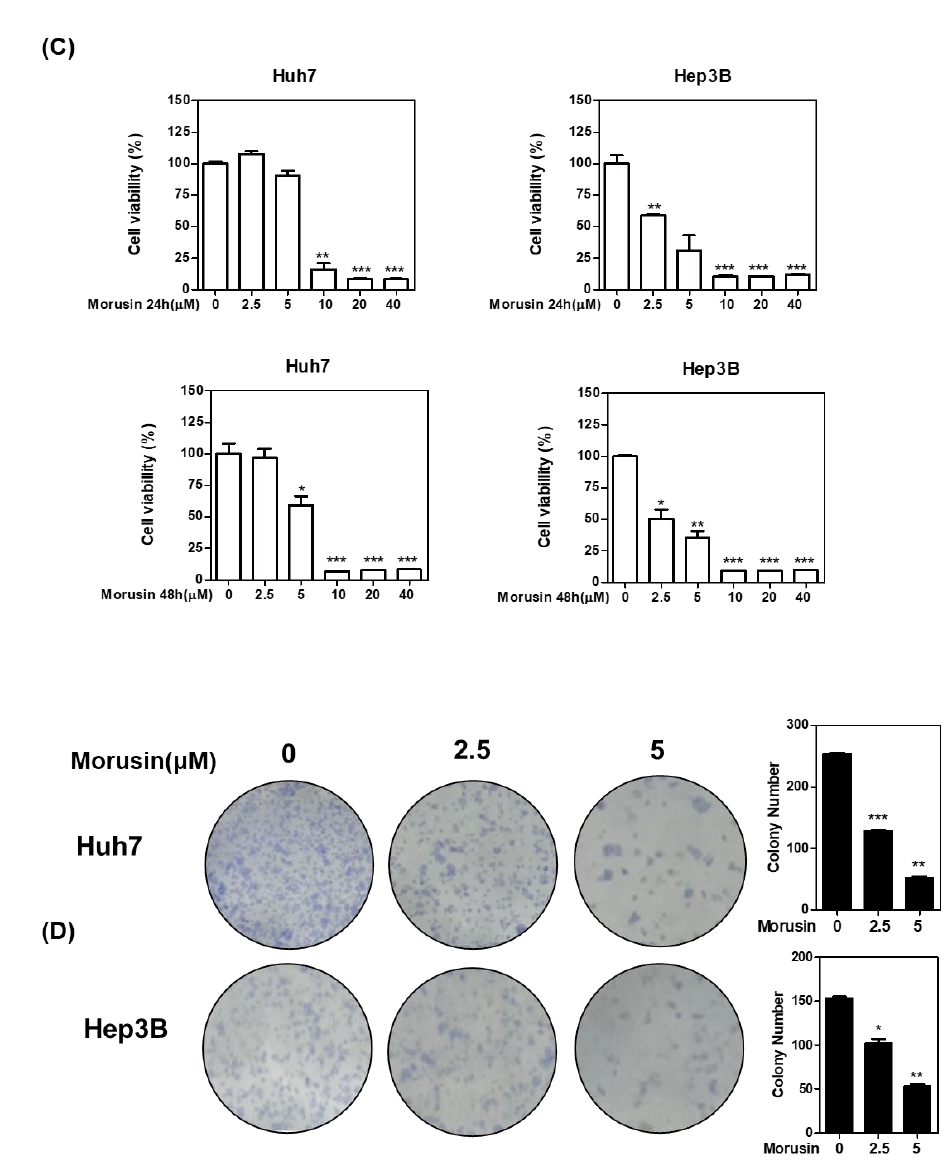
Figure 1. Chemical structure of Morusin and its effect on cytotoxicity in HCCs. ( A ) Chemical structure of Morusin ( B ) Effect of Morusin on the viability of Huh7 and Hep3B cells by MTT assay. Huh7 and Hep3B cells were seeded into 96-well microplates and treated with various concentrations (2.5, 5, 10, 20, and 40 µM) of Morusin for 24 h and 48 h. Cell viability was measured by MTT assay. * P < 0.05, **, P < 0.01, ***, P < 0.001 vs. untreated control. ( C ) Effect of Morusin on Huh7 and Hep3B cells. Cells were cultured with Morusin (0–40 μM) for 24 h and 48 h and then measured by CCK-8 assay ( D ) Effect of Morusin on the number of colonies in Hep3B cells by colony formation assay. Huh7 and Hep3B cells were seeded onto 6-well plates for a week. Then the colonies stained with crystal violet were counted. Data represent means ± SD. *, P < 0.05, **, P < 0.01, ***, P < 0.001 vs. untreated control ( n = 3).